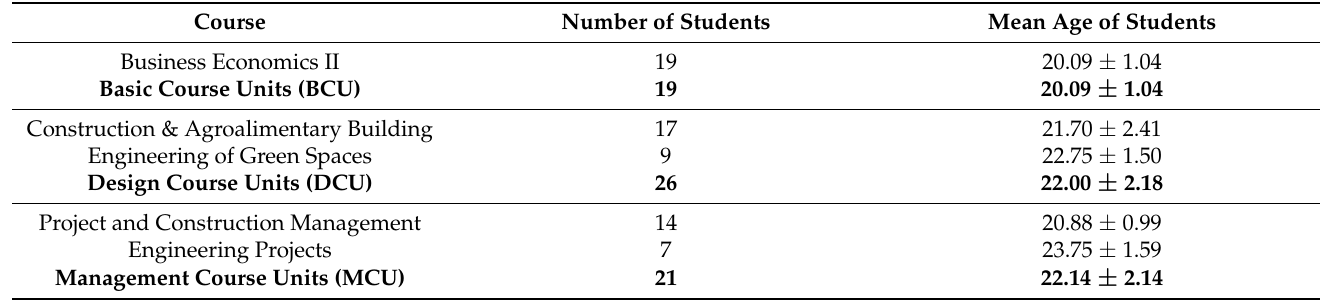
Table 1. Mean age of students for each course